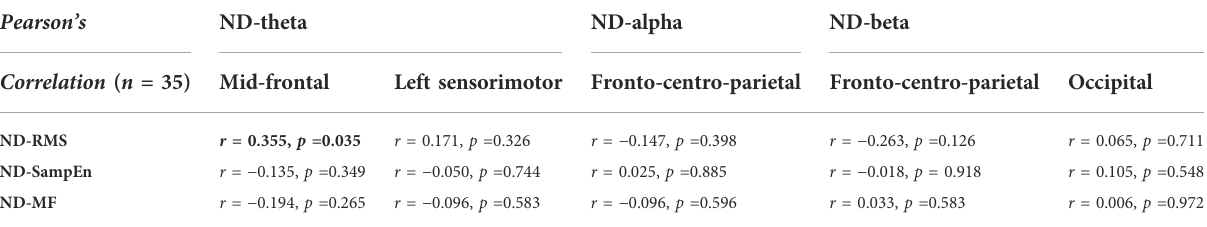
TABLE2Pearson ’ scorrelationbetweenchangesinregionalspectralactivityandstabilometerdynamicsduetostroboscopicvision.Theblack-bolded fonts in the shaded areas indicate signi fi cant correlations of regional activity and postural sway dynamics. Pearson ’